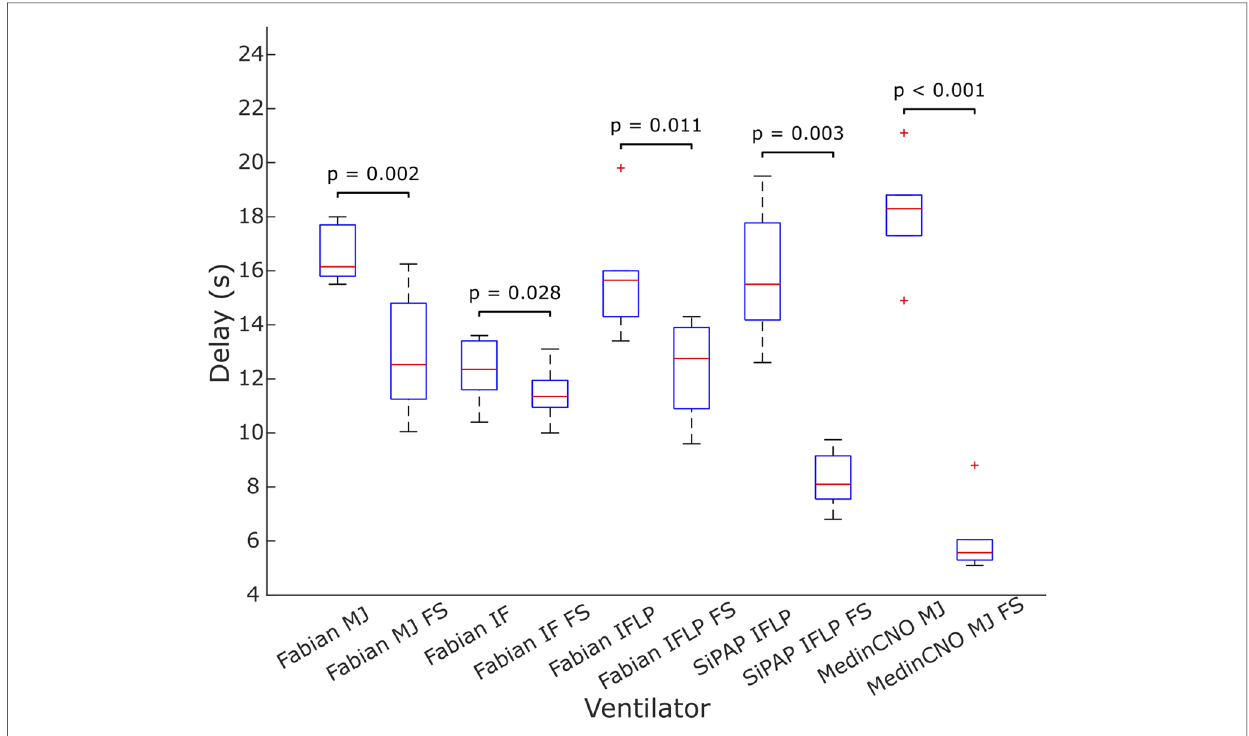
FIGURE 8 Delay in oxygen delivery upon a 30% increase in FiO 2 without the O 2 -FS and with the O 2 -FS. Fabian MJ, Fabian with Medijet interface; Fabian IF, Fabian with Infant Flow interface; Fabian IFLP, Fabian with Infant Flow Low Pressure; SiPAP IFLP, Vyaire SiPAP with Infant Flow Low Pressure interface; Medin MJ, Medin MedinCNO with Medijet interface. FS marks a con fi guration with the O 2 -FS. Each box plot displays the following information: median (red line), lower and upper quartiles (blue rectangles), outliers (red crosses), and minimum and maximum values that are not outliers (black